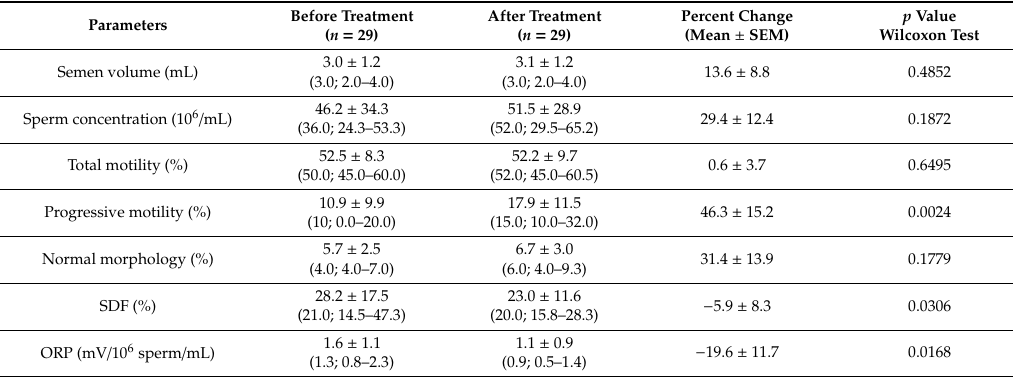
Table 6. Summary statistics of semen parameters, SDF, and ORP before and after the treatment of unexplained male infertility patients with FH PRO for